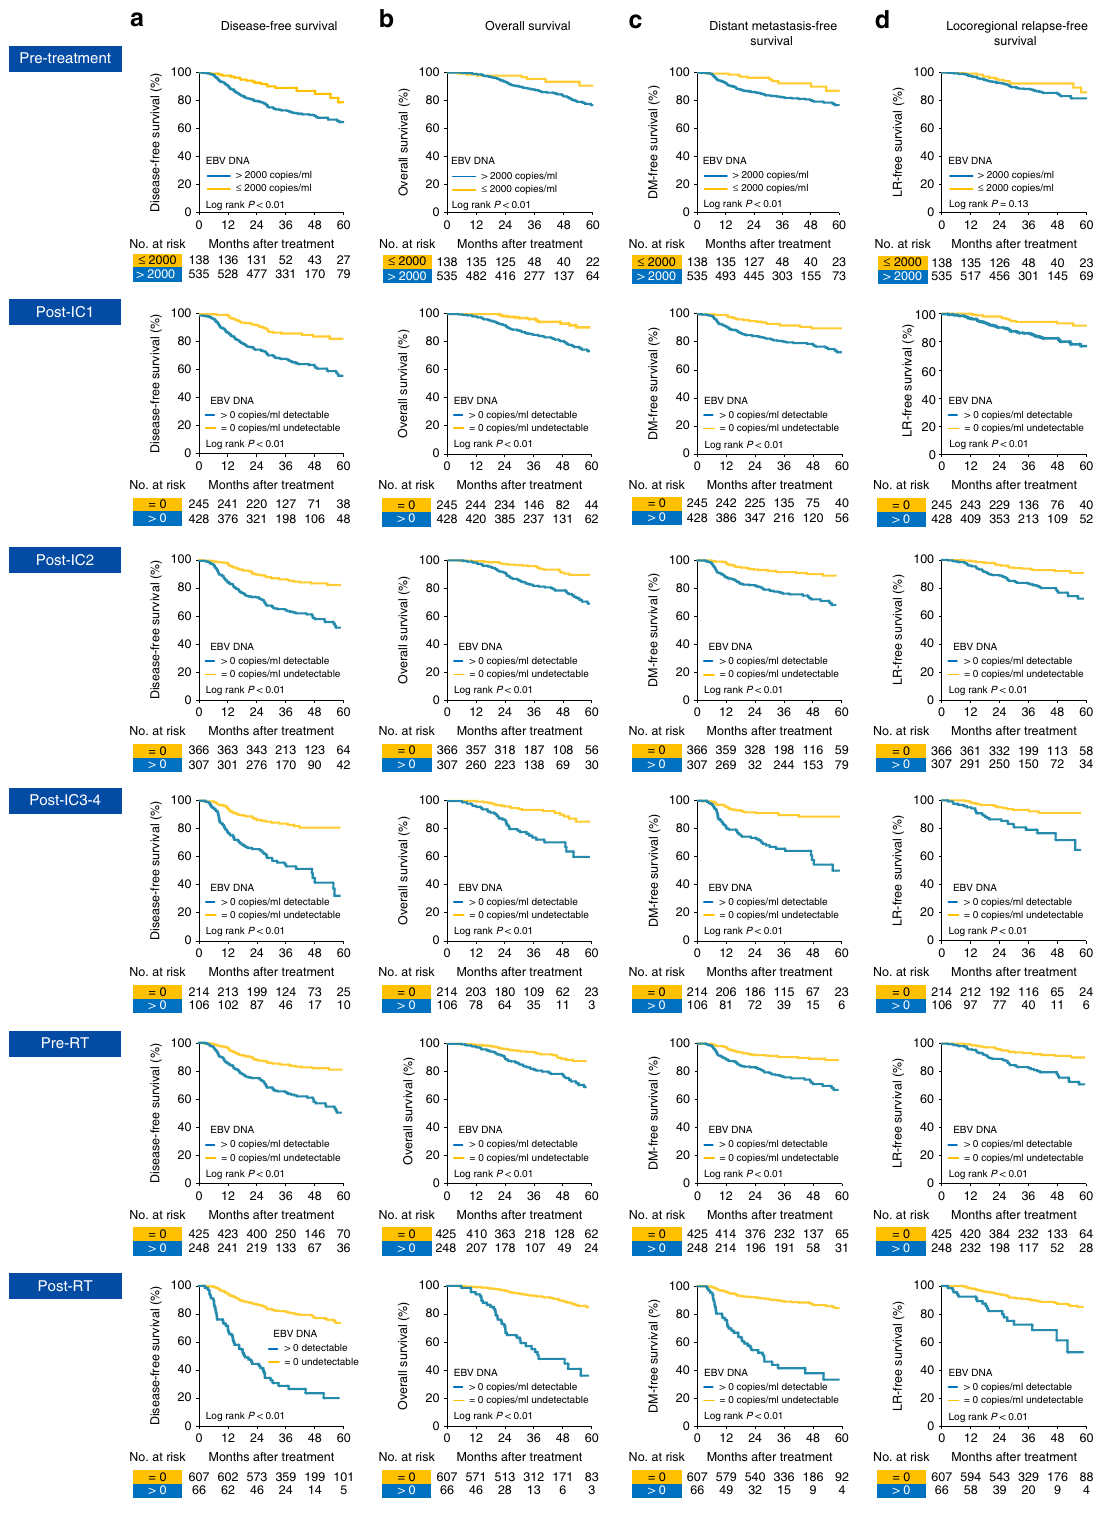
Fig. 2 Kaplan – Meier plots of survival outcomes for subgroups achieving complete biological response at different time points. a Disease-free survival (DFS). b Overall survival (OS). c Distant metastasis-free survival (DMFS). d Locoregional relapse-free survival (LRFS). Time points included pretreatment, post-IC 1 , post-IC 2 , post-IC 3-4 , pre-radiotherapy and post-concurrent